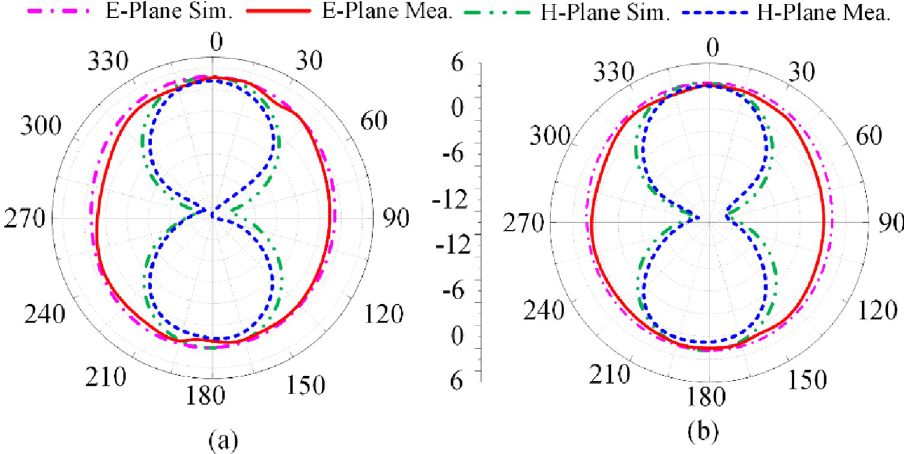
Fig 11. Radiation pattern of proposed antenna when both PIN diodes are forward biased at (a) 2.45 GHz, and (b) 3.5